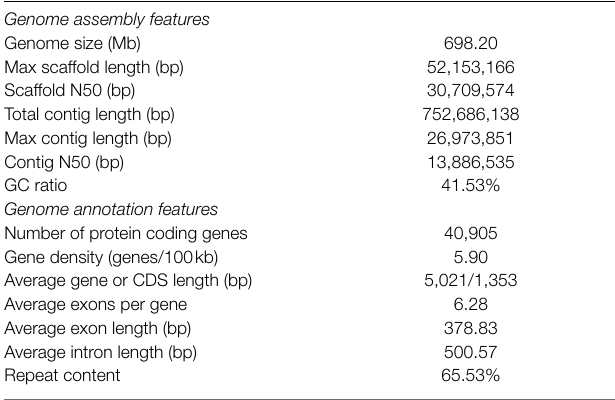
TABLE 1 | Assembly and annotation characteristics of the Pohlia nutans genome. Genome assembly features Genome size